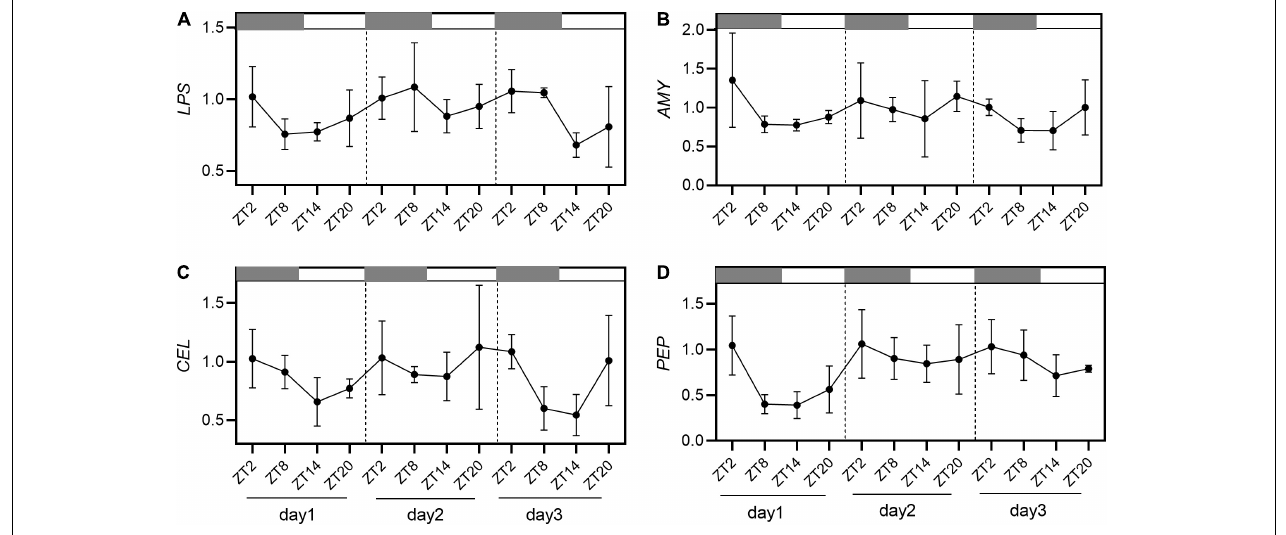
FIGURE 3 | Relative gene expression of LPS (A) , AMY (B) , CEL (C) , and PEP (D) in 12 h light/12 h dark (L/D) cycles during 3 days. Values are represented as means ± SD ( n = 4). The gray grid represents the dark time